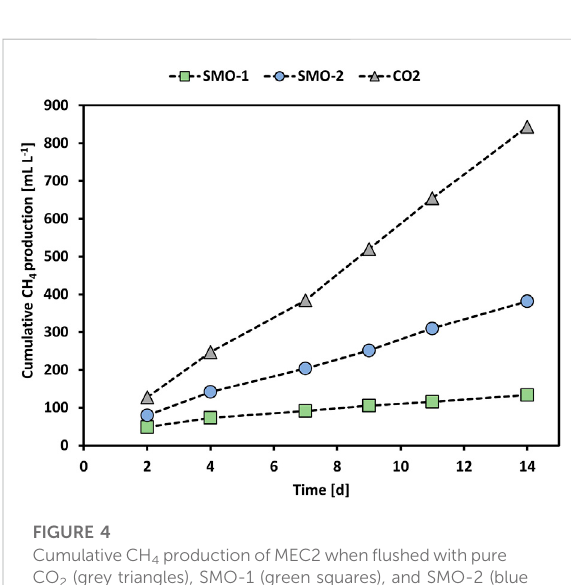
FIGURE 4 CumulativeCH 4 production ofMEC2 when fl ushedwithpure CO 2 (grey triangles), SMO-1 (green squares), and SMO-2 (blue